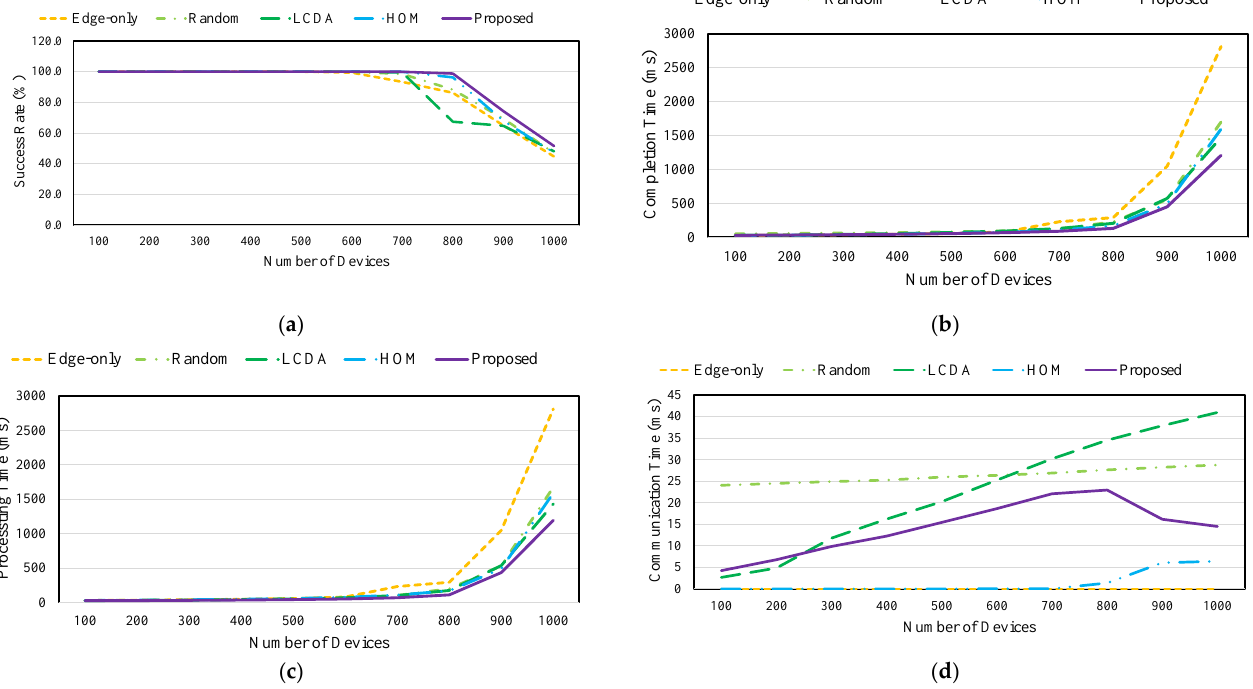
Figure 5. QoE of collaboration schemes for Task 1: ( a ) Success rate; ( b ) Completion time; ( c ) Processing time; ( d ) Communication time.